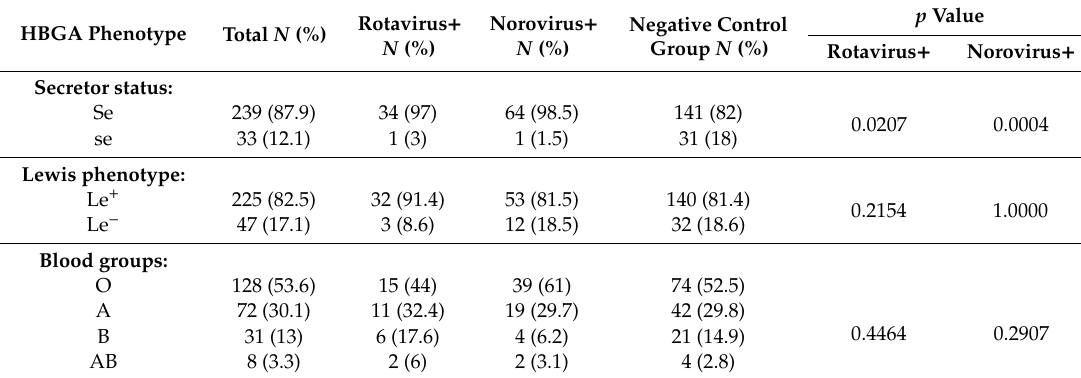
Table 3. Distribution of histo-blood group antigens (HBGAs) phenotypes between children infected with rotavirus / noroviruses and the negative control